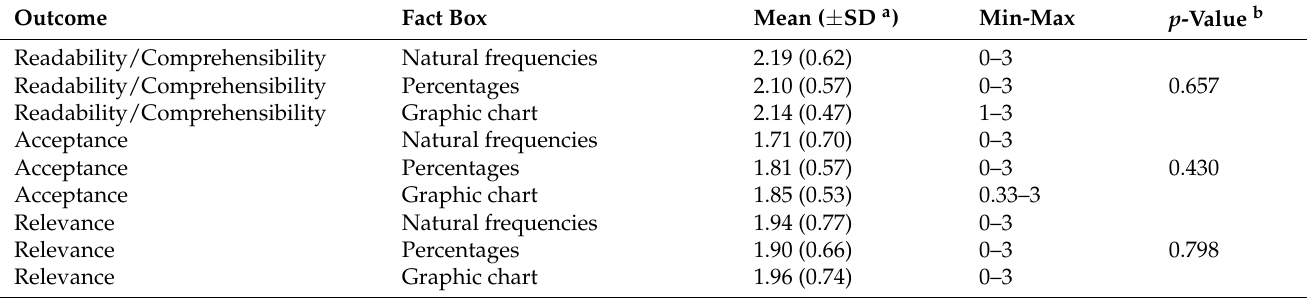
Table 3. Participants’ responses regarding readability/comprehensibility, acceptance, and